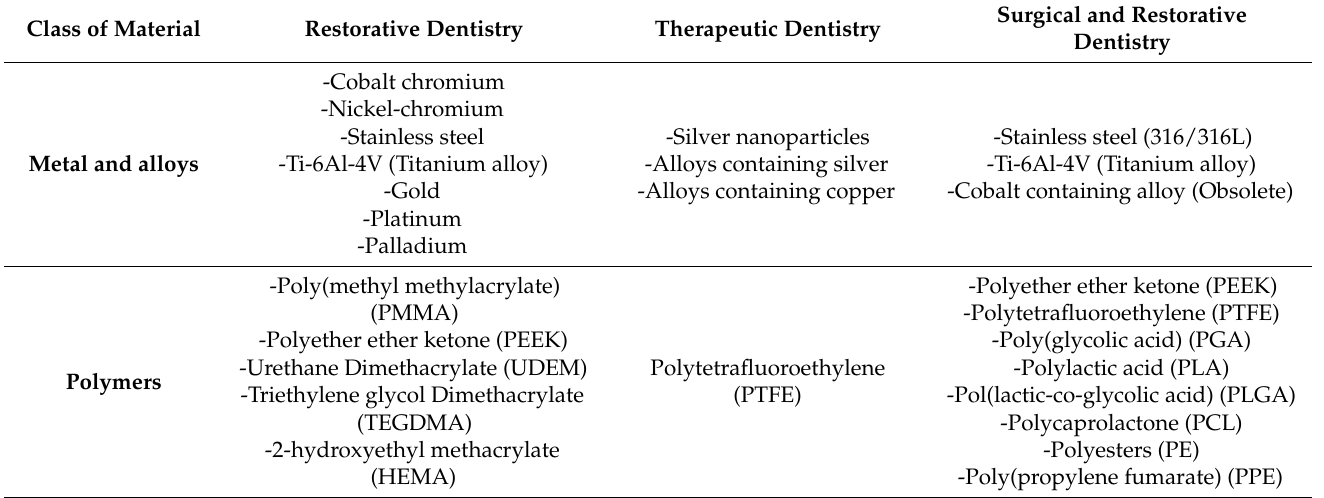
Table 1. A classification of different biomaterials with examples of their respective applications in the field of